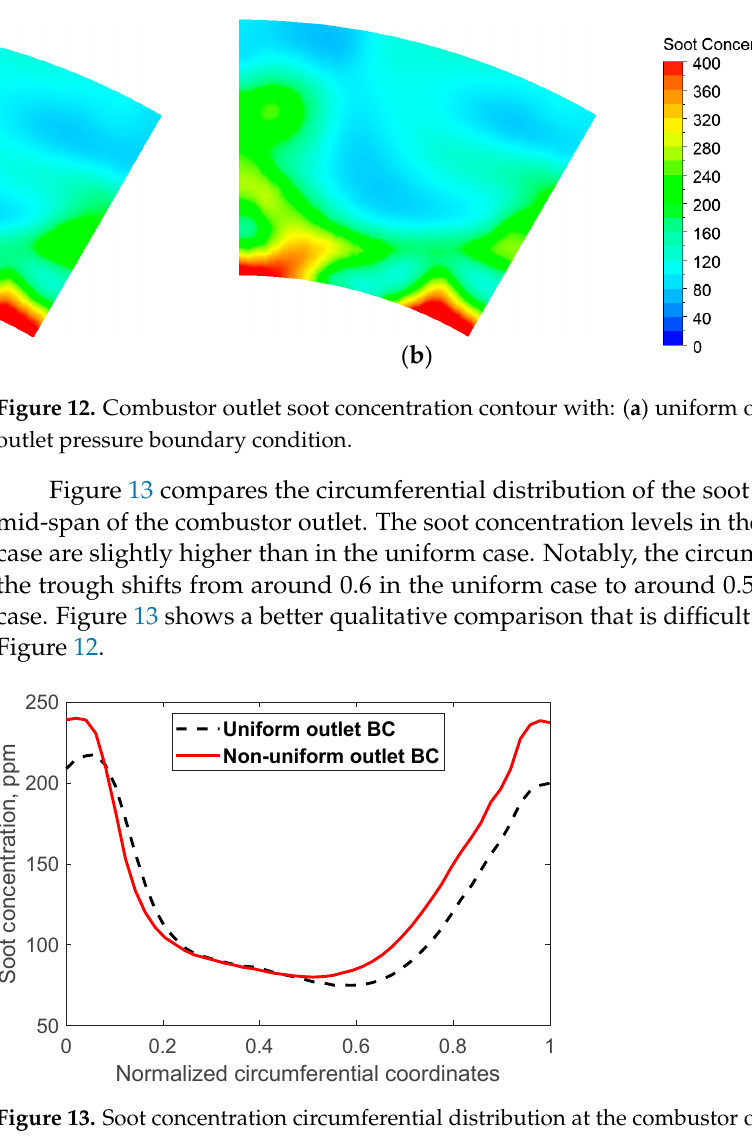
Figure 13. Soot concentration circumferential distribution at the combustor outlet mid-span.